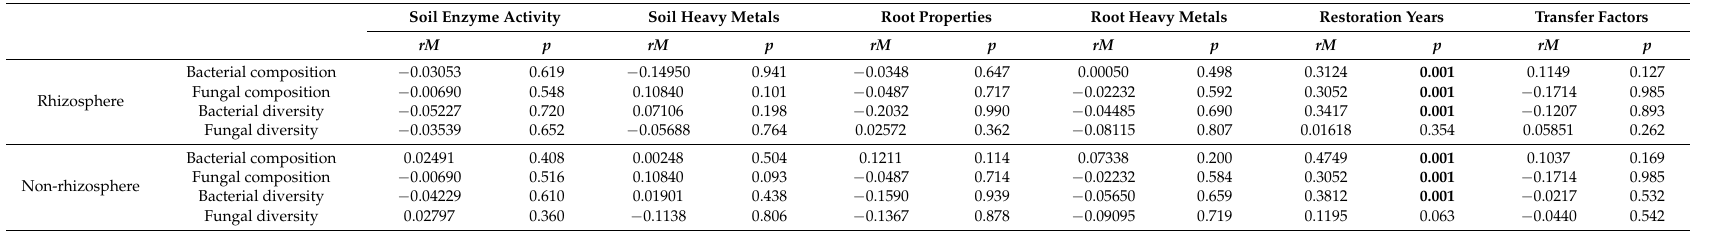
Note: Significant p -values are in bold